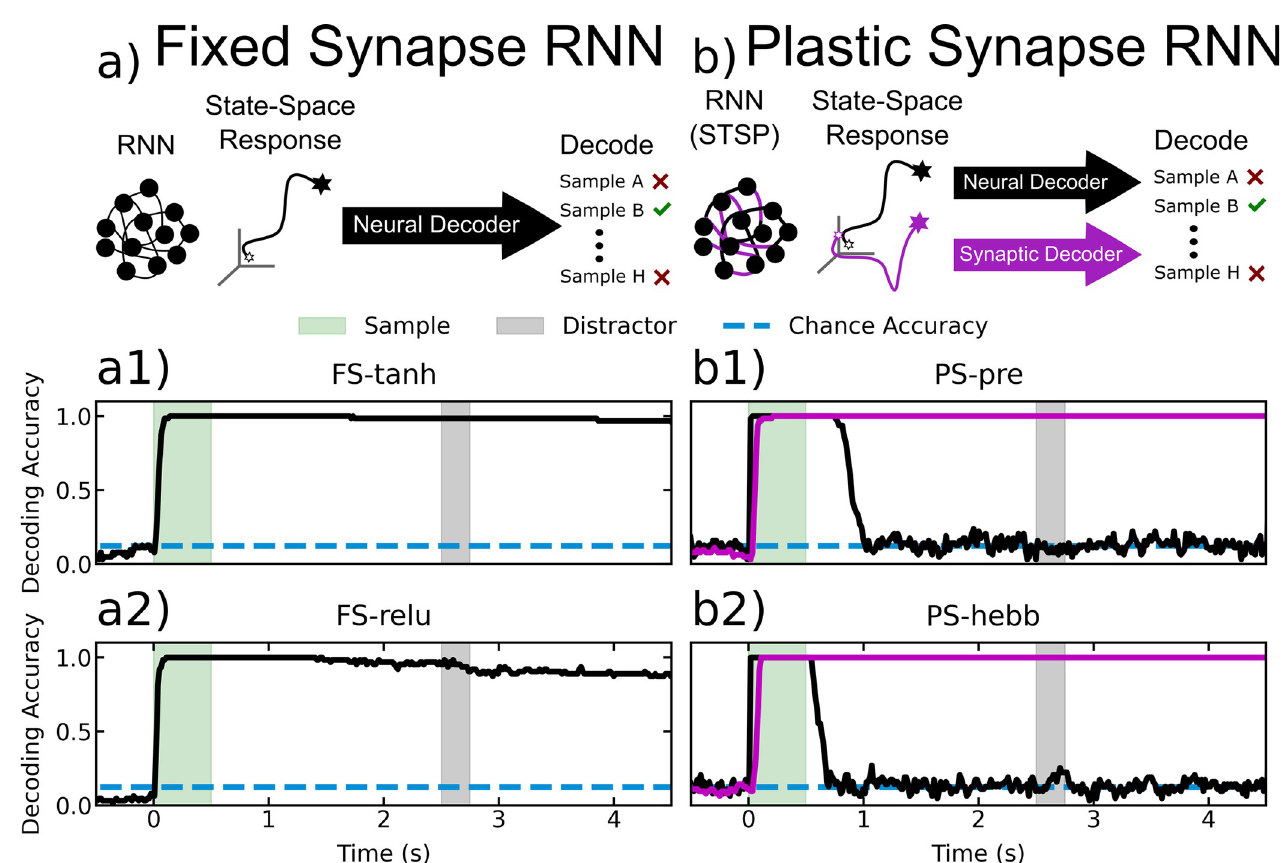
Fig 4. Decoding accuracy for RNNs. a) A decoder is trained to predict the sample label from RNN neural trajectories, for the fixed-synapse RNNs. a1) The accuracy of the trained decoder as a function of time from sample onset for FS-tanh. a2) The same plot as (a1), for FS-relu. b) Two decoders are trained on the neural and synaptic trajectories separately. Black lines indicate neural decoding, purple indicate synaptic decoding. b1) Neural and synaptic decoding accuracy as a function of time for PS-pre. b2) Same plot as in (b1) but for PS-hebb.